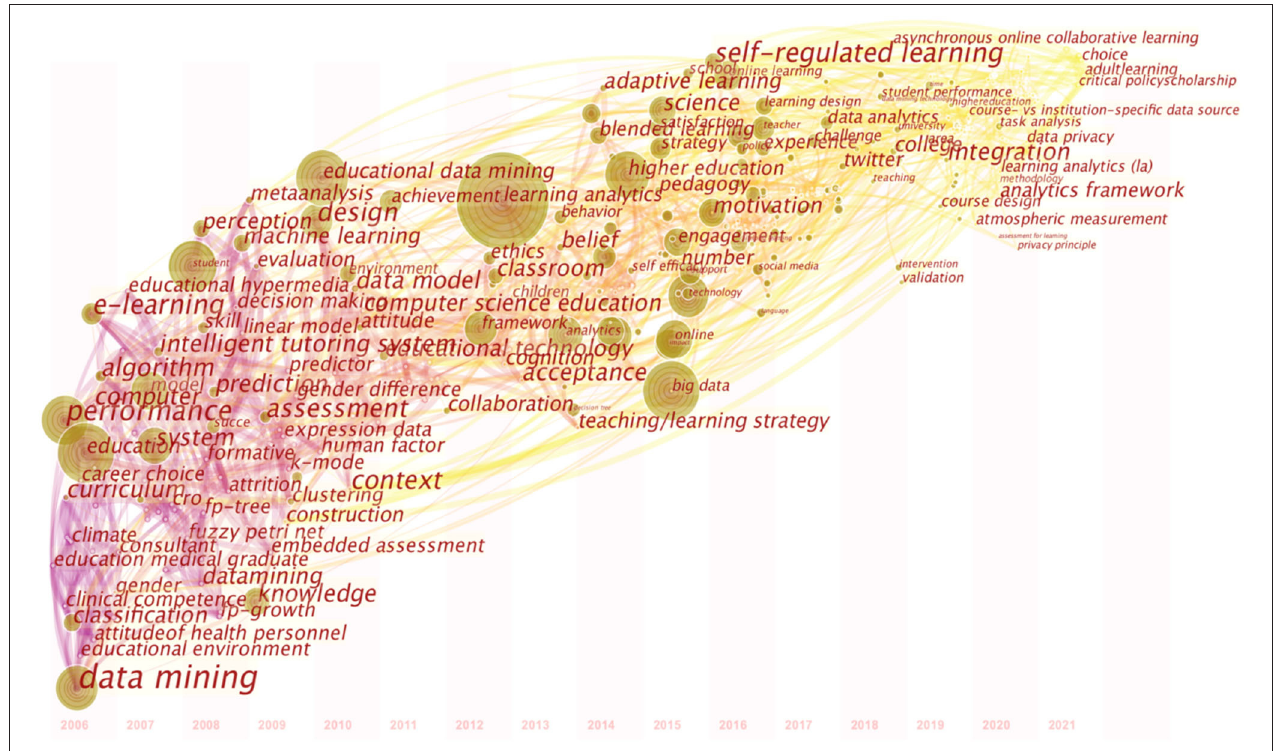
FIGURE 7 | Keywords Timeline view based on CiteSpace.